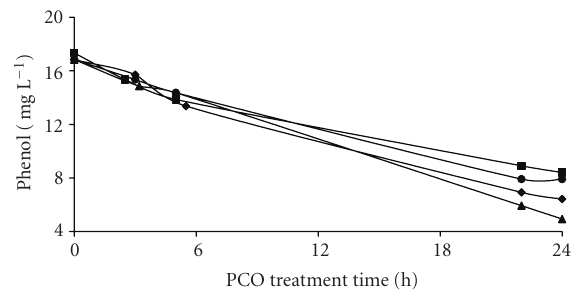
Figure 4: The decrease of phenol concentration in PCO treatment time at di ff erent pH: pH 3 ( (cid:2) ), pH 7 ( ♦ ), pH 9 ( (cid:3) ), pH 11 ( • ); ini- tial concentration of lignin 100mg L − 1 ; plate 0.75 mg cm − 2 (spray-